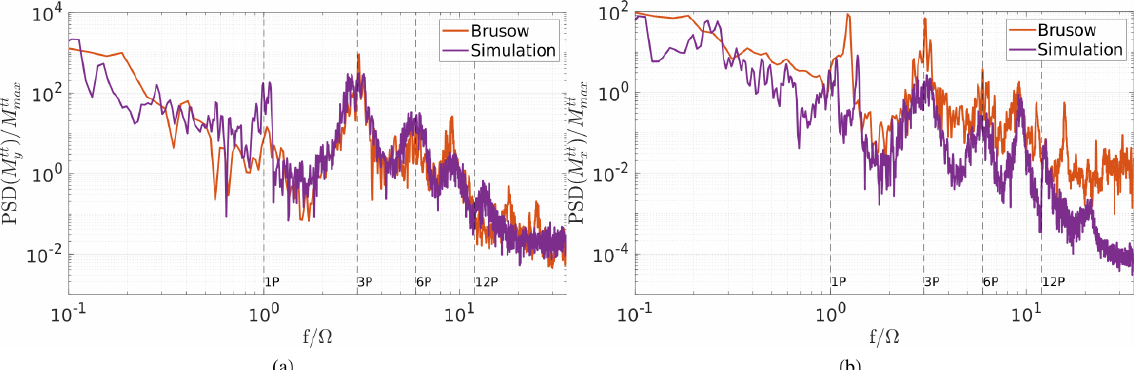
Figure B2. Spectrum of the tower top bending moment in (a) the fore-to-aft direction M tt y and (b) the side-to-side direction M tt x ; comparison of the measurement data to the simulation results (neutral). The data are normalised by the maximum value of the tower base bending moments, and the frequency is normalised by the rotor